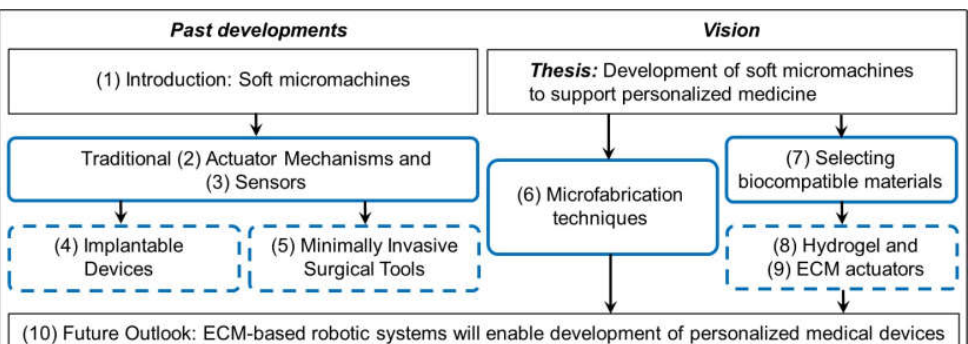
Figure 2. Overview of this review including sections and thesis. Section number in (), solid black line outlines themes and thesis, solid blue lines outline fabrication techniques, and dashed blue line outlines applications.